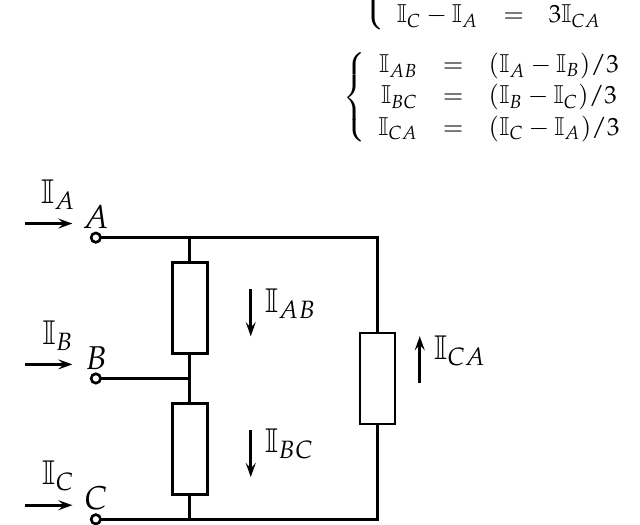
Figure A4. Phase currents